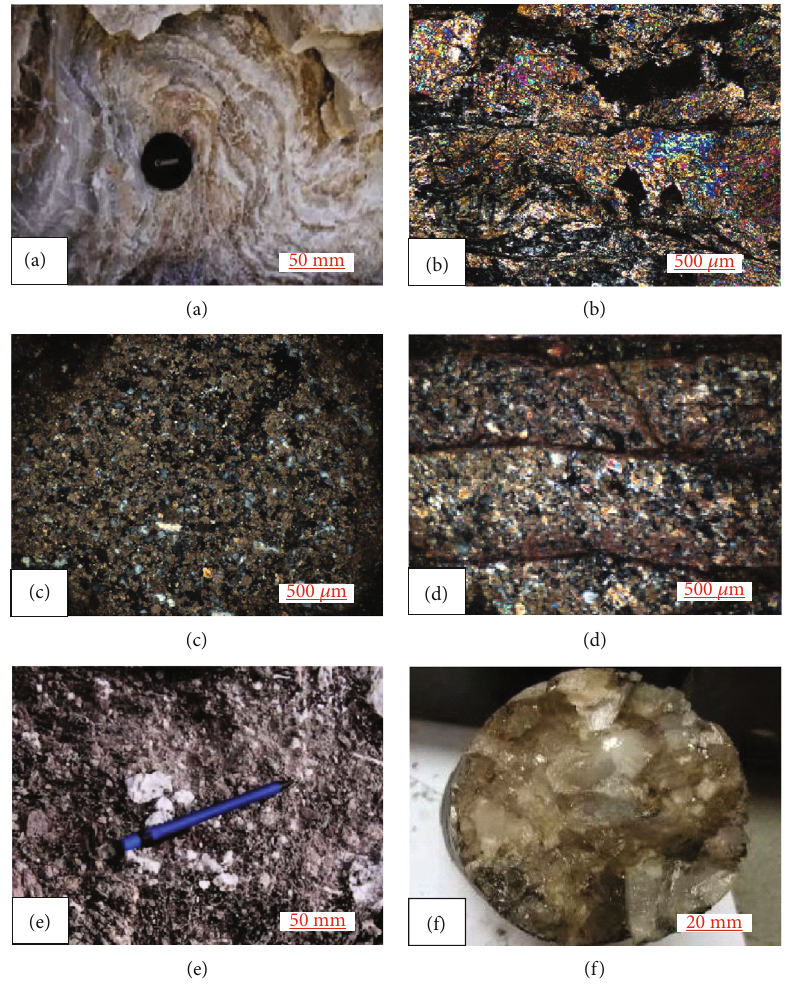
Figure 3: Petrological characteristics of evaporites in DEPS: (a) rhythmic banded gypsum, Shapingzi, Leibo County, Xixiangchi Formation [27]; (b) gypsum, Loutan 1 Well, 5595m (+); (c) dolomite gypsum rock, Loutan 1 well, 5931 m (+); (d) dolomite-bearing gypsum rock, Loutan 1 well, Gaotai formation footwall, 6558 m (+); (e) Gypsum karst breccia, Heima, Ganluo County [27]; and (f) salt rock (potassium salt), Loutan 1 Well, 6050 m, core